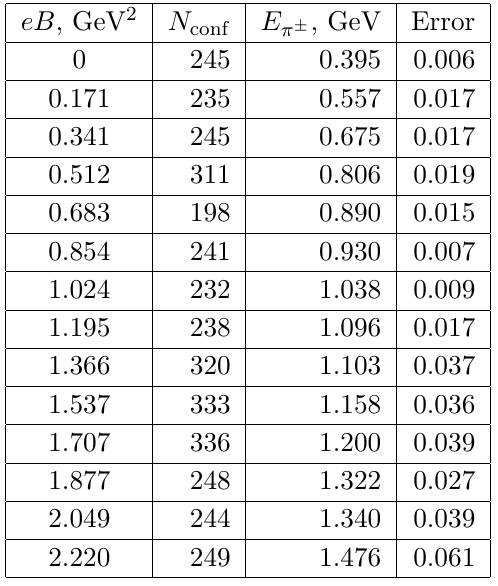
Table 1 . The values of the (cid:25) (cid:6) energy, its errors and the number of lattice con(cid:12)gurations, which were used for the calculations at lattice volume 18 4 , lattice spacing a = 0 : 115 fm, bare quark mass 17 : 13 MeV and various MF values.